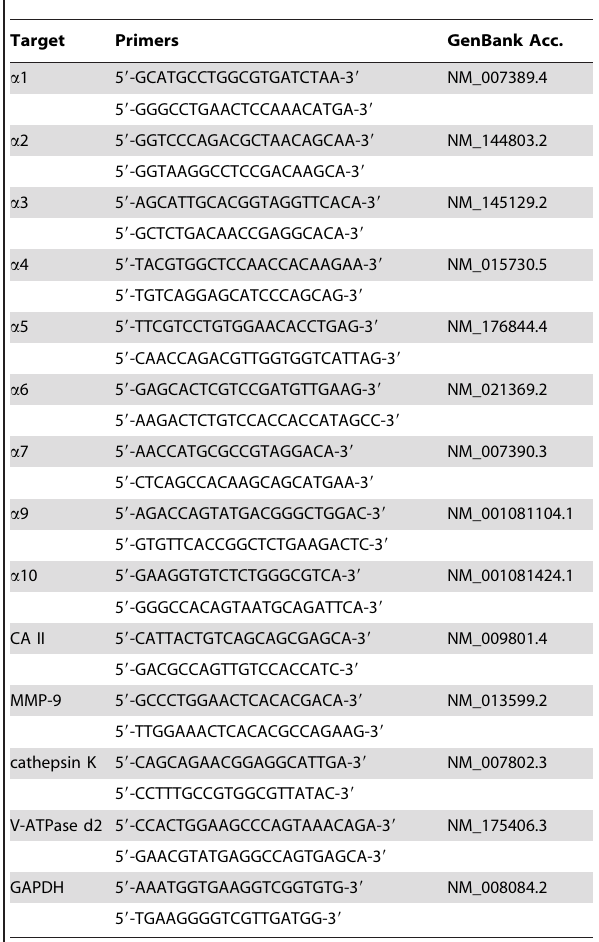
Table 1. PCR primers used in the